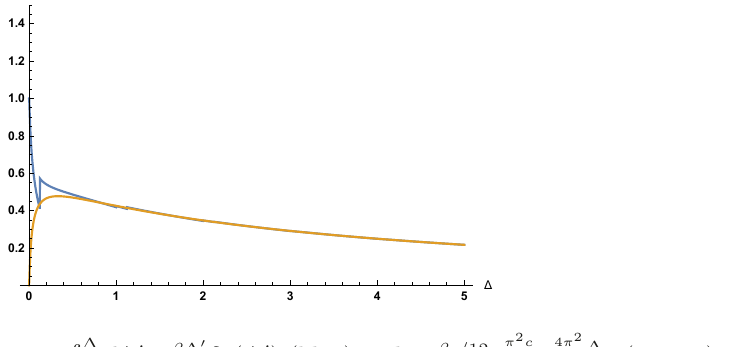
Figure 4 . The difference